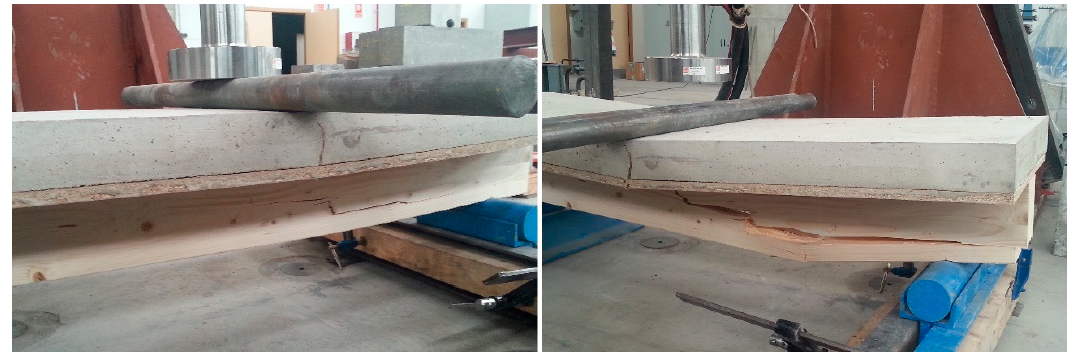
Figure 15. Final appearance of the specimens after the flexural test.